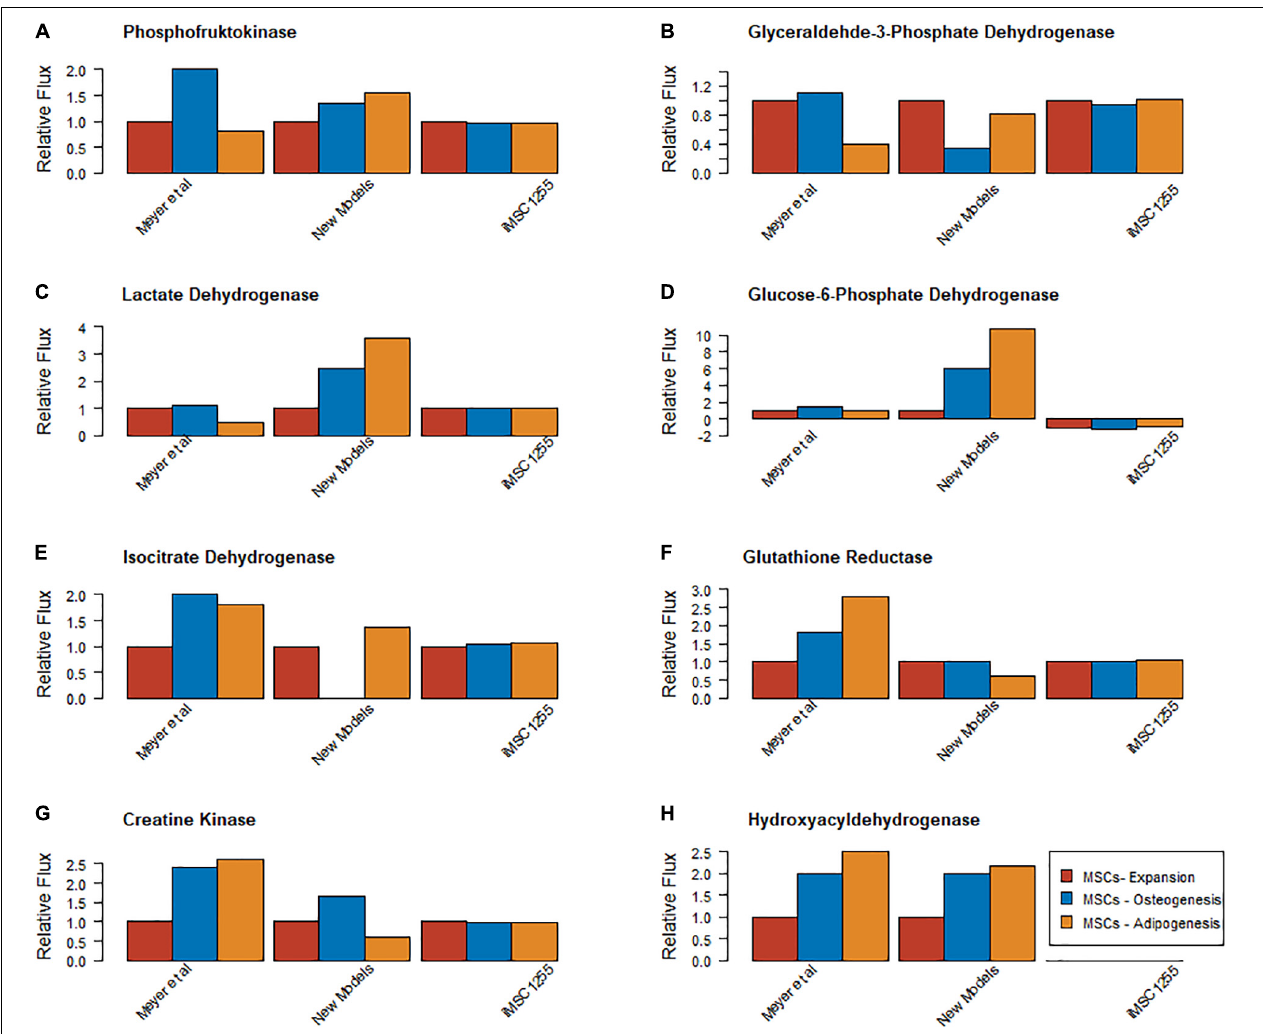
FIGURE 4 | Comparison of relative magnitude of metabolic fluxes found at day 7 of expansion, osteogenic and adipogenic differentiation in Meyer et al. (2018), iMSC1255 er-constrained with MS data collected in Iceland and the new models (A) Phosphofructokinase (B) Glyceraldyhyde 3 phosphate